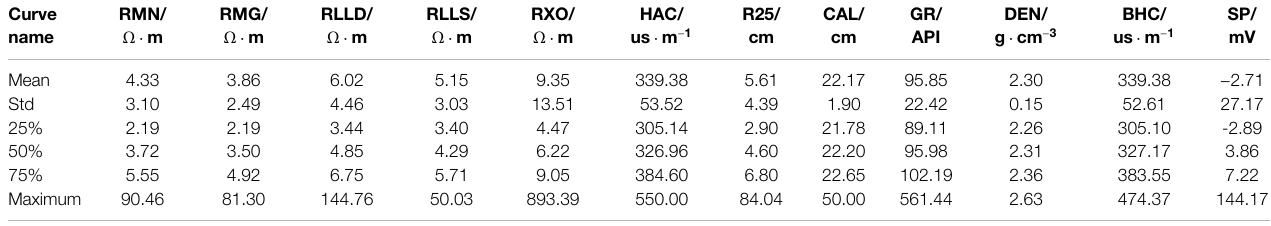
TABLE 2 | Statistical summary of 12 logging curves.